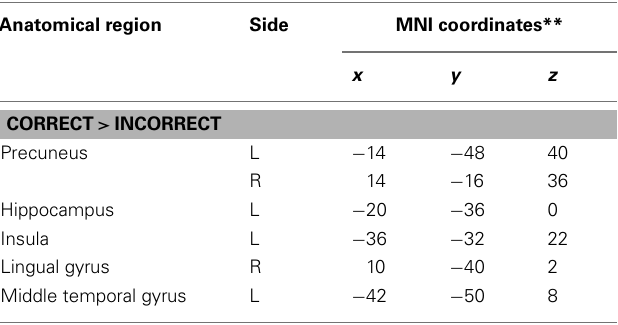
Table 1 | Group activations for the contrast between correct versus incorrect answers (RP), p < 0.001, uncorrected.